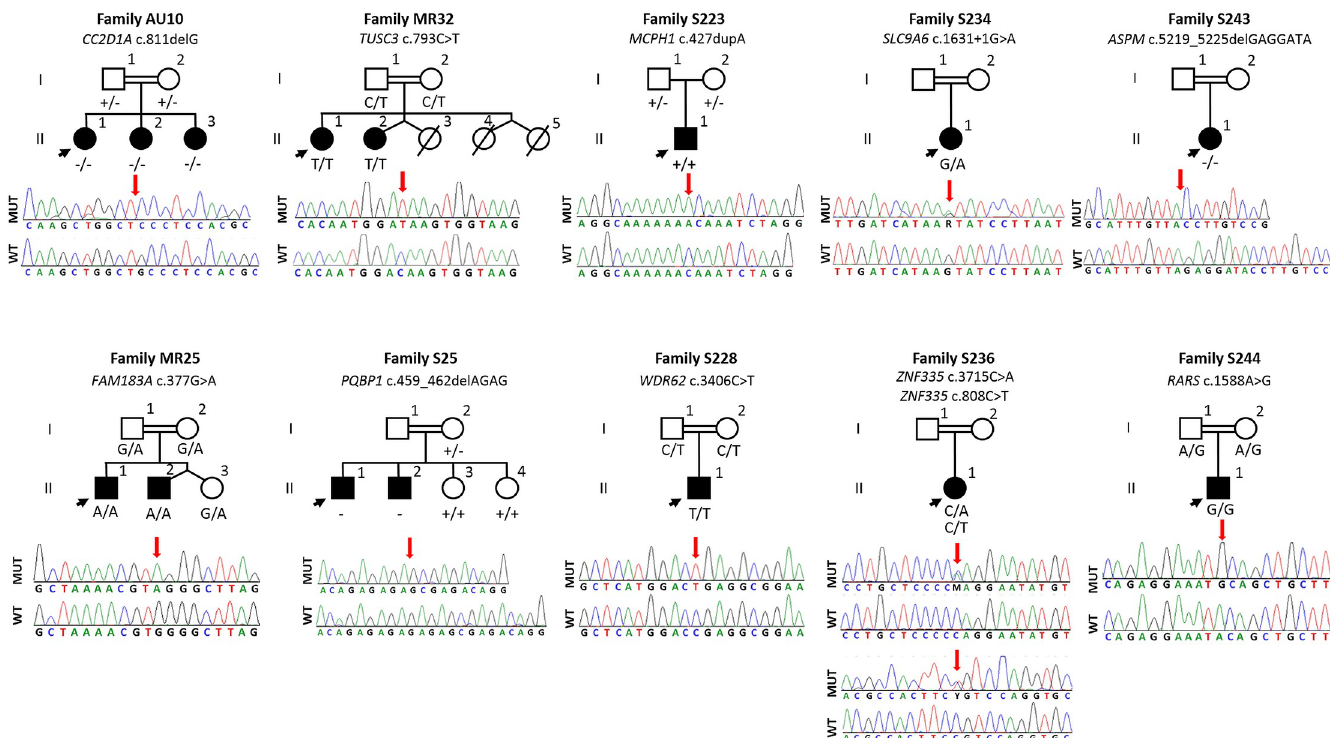
Fig 1. The electropherograms of the identified variants and pedigrees of the families in this study. WT: Wildtype, MUT: Mutant.